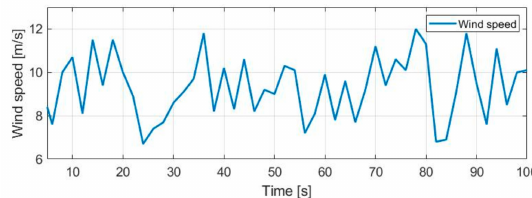
Figure 8. Wind speed (m / s) (variation profile for case 1 and case 2.